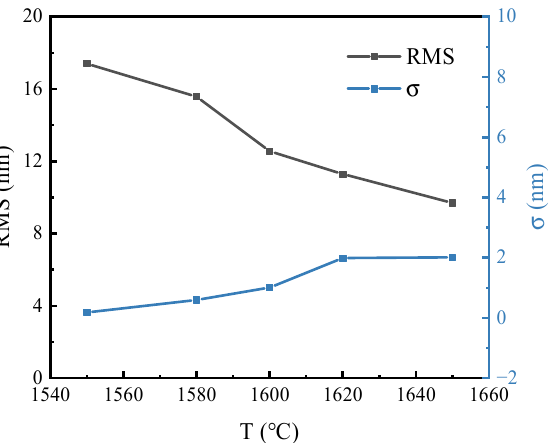
Figure 7. RMS and σ as a function of growth temperature, the growth temperature is 1550, 1580, 1600, 1620, and 1650 °C, respectively.